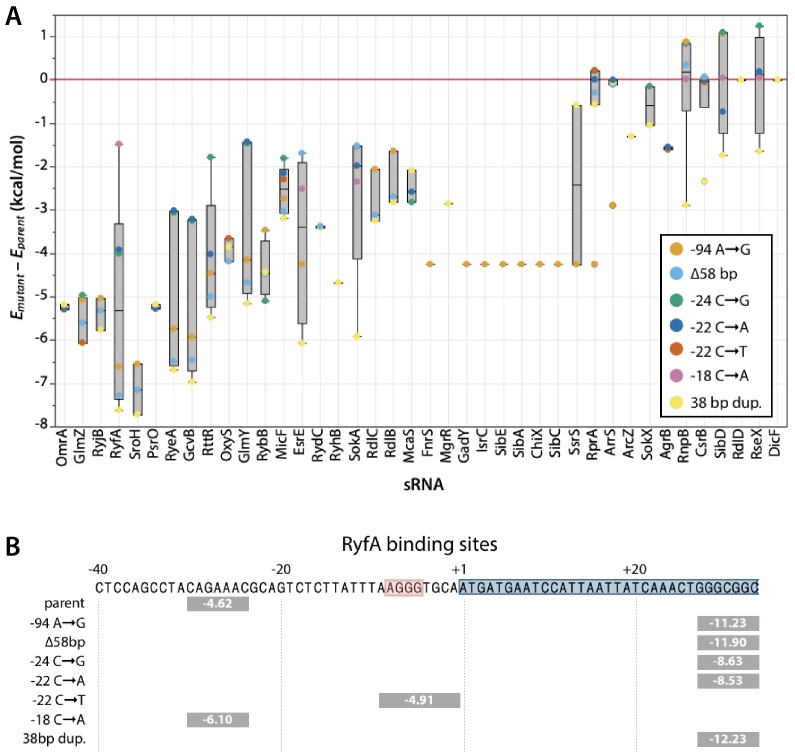
Difference in calculated energies for hybridization of sRNAs to mutant and parental argB sequences.(A) Each box plot represents the calculated ∆E for sequences with mutations upstream of argB (the mutants shown in Figure 6A except for the ∆51 bp mutant) for each annotated sRNA in the E. coli genome. Points were excluded if Emutant > −5 kcal/mol, as those interactions are likely too weak to be physiologically relevant. ∆E < 0 indicates a stronger sRNA-mRNA interaction for the mutant sequence. ∆E > 0 indicates a weaker sRNA-mRNA interaction for the mutant sequence. (B) Predicted locations of binding of RyfA to the region upstream of argB. Predicted E (kcal/mol) is displayed for each binding site. Blue, 5’ region of argB; red, expected ribosome binding site.